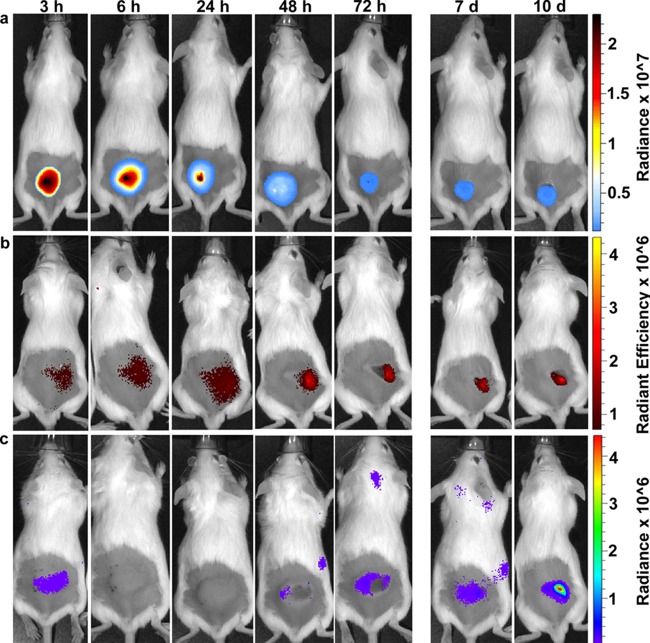
In vivo tracking of P. aeruginosa LESB58 infection. The infection progress was monitored at the indicated time points (from 3 h to 10 days postinfection). CD-1 mice were injected with a high number of bacteria (5 × 107 CFU). (a) In vivo tracking of bioluminescently labeled (live) bacteria showed stable expression of the reporter gene that slowly decreased over time. While a high signal was observed 3 h postinfection, the intensity after 6 h got weaker and was more extensively spread around the tissue swelling. Starting on day 3, the signal was focused at the visible dermonecrotic region. Decreasing luminescence in the first 3 days, despite a modest 3- to 10-fold increase in bacterial numbers, might have been due to decreased metabolic activity under the conditions of the high-density infections, which would influence energy-dependent enzyme activity and/or plasmid copy number. (b) Mice were injected i.v. with a fluorescent neutrophil-specific NIR probe. The signal was scattered around the injection site until day 1 and focused at the necrotic tissue from day 2 onward. (c) ROS and RNS production was tracked using the chemiluminescent probe L-012 (injected between the ears). ROS/RNS production was turned on within 3 h postinfection, rapidly disappeared after 6 h, and reappeared after 24 h. (a to c) Mice were imaged using an in vivo image system (IVIS) for a maximum of 10 days. The experiment was repeated at least three times with a minimum of two mice/group.